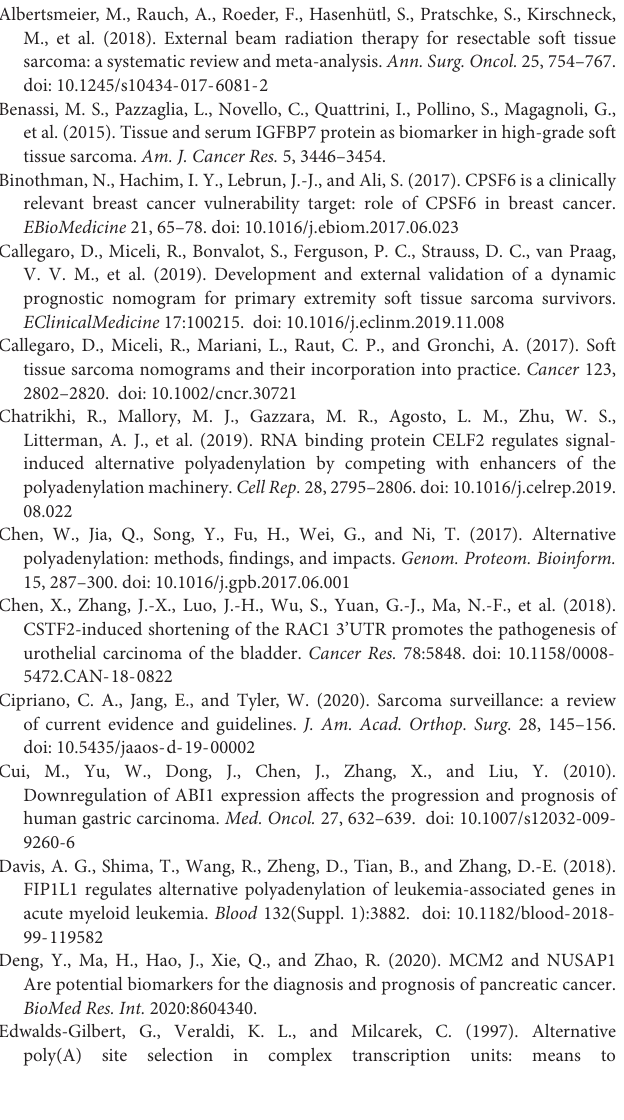
selection operator; APA, alternative polyadenylation; OS, overall survival; PFS, progress free-survival. Supplementary Figure 2 | The distribution of clinical covariates across low- and high-risk groups. (A) Overall survival signature; (B) Progress free-survival signature. DLP, dedifferentiated liposarcoma; LMS, leiomyosarcoma; MFS, myxofibrosarcoma; UPS, undifferentiated pleomorphic sarcoma. Supplementary Figure 3 | Subgroup analyses of OS signature. Survival curves showed that high-risk patients were significant worse OS than low-risk patients in subgroups of age (A) , sex (B) , cancer histological type (C,D) , metastatic status (E) , tumor site (F) , margin status (G) , and multifocal indicators (H) . OS, overall survival. Supplementary Figure 4 | Subgroup analyses of PFS signature. Survival curves showed that high-risk patients were significant worse PFS than low-risk patients in subgroups of age (A) , sex (B) , cancer histological type (C,D) , metastatic status (E) , tumor site (F) , margin status (G) , and multifocal indicators (H) . PFS, progress-free